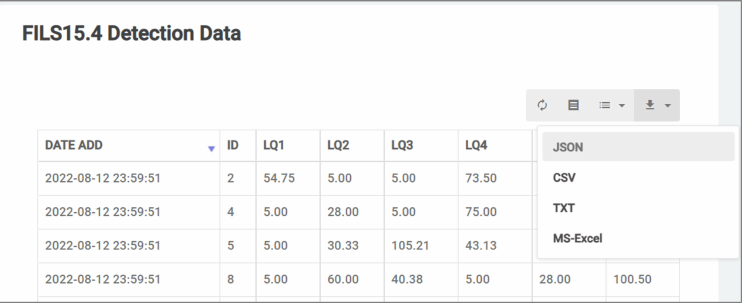
Figure 5. Data export